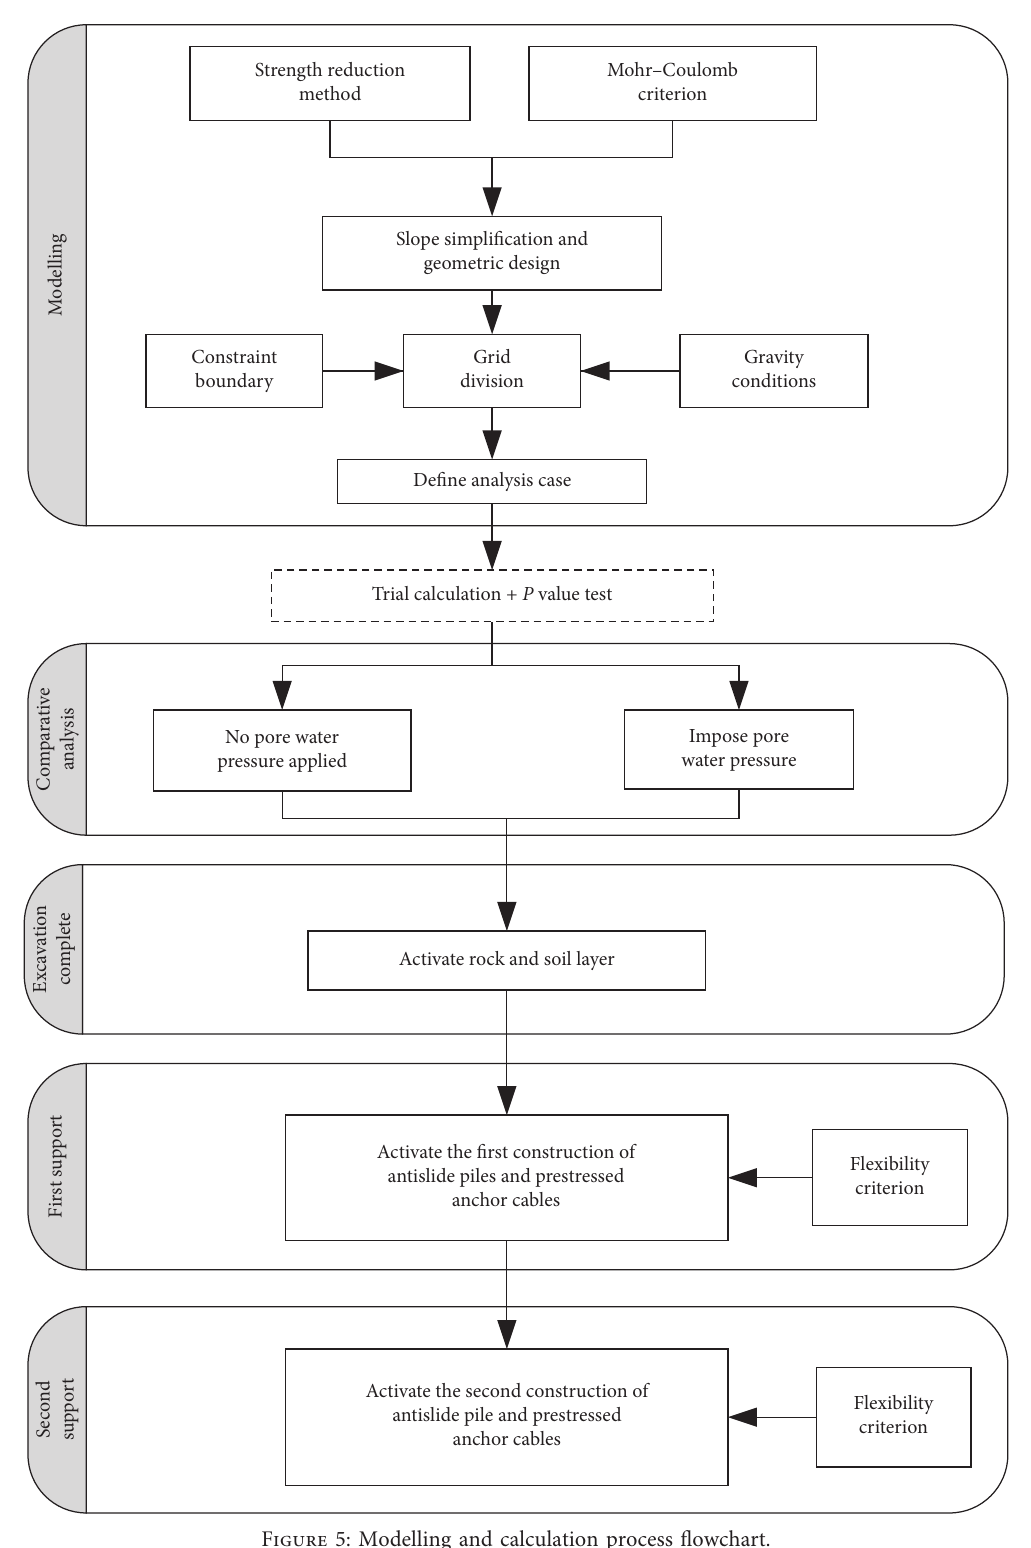
Figure 5: Modelling and calculation process